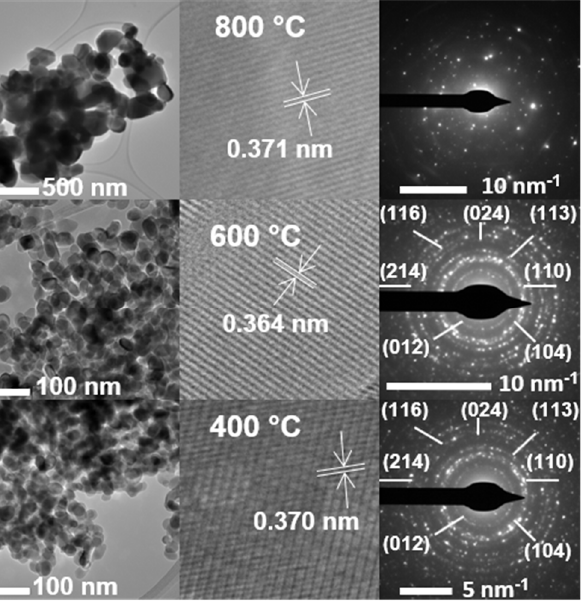
Figure 12. (From left to right) TEM, HRTEM, and SAED patterns of 100 Fe:5 K calcined at (from top to bottom), 800, 600, and 400 °C.